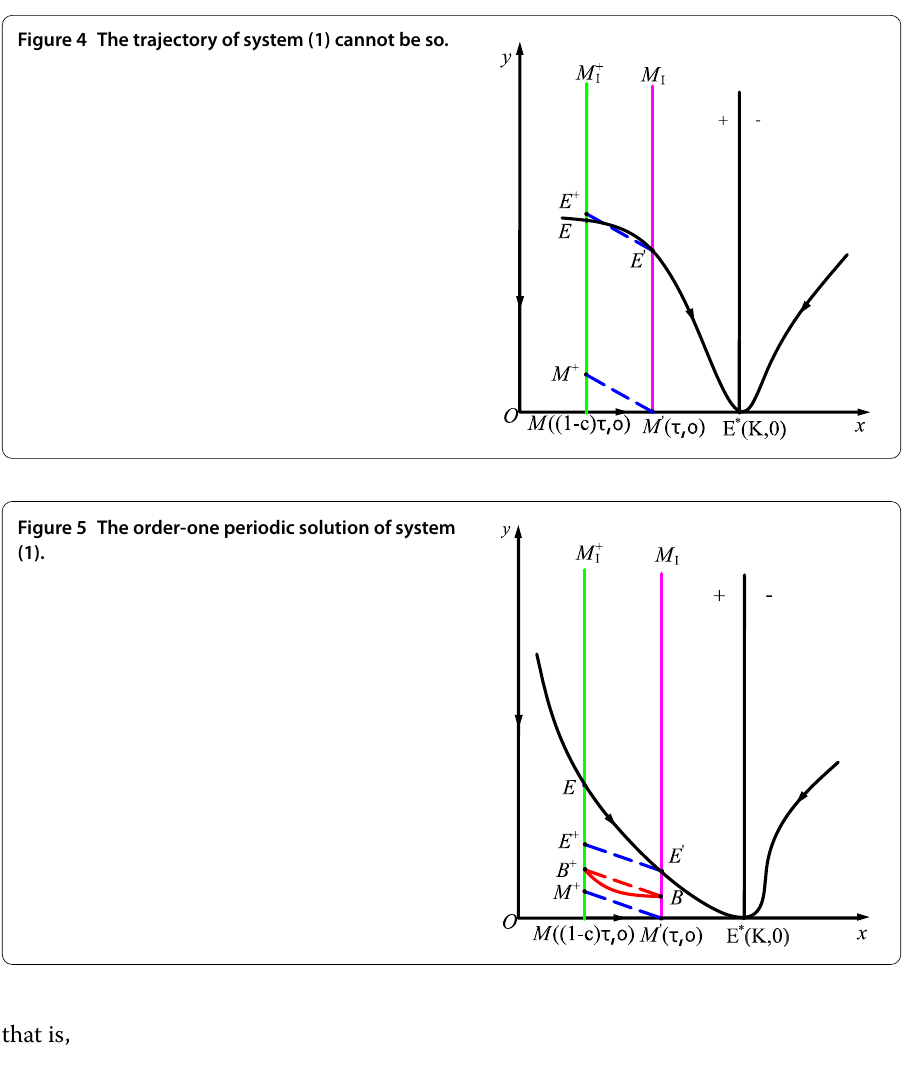
Figure 4 The trajectory of system (1) cannot be so.